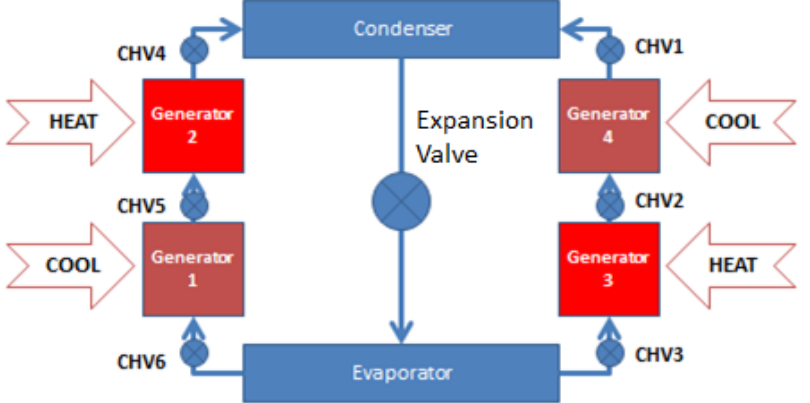
Figure 1. Schematic for two-stage adsorption chiller. Modes of Operation for Two-Stage Adsorption Chiller